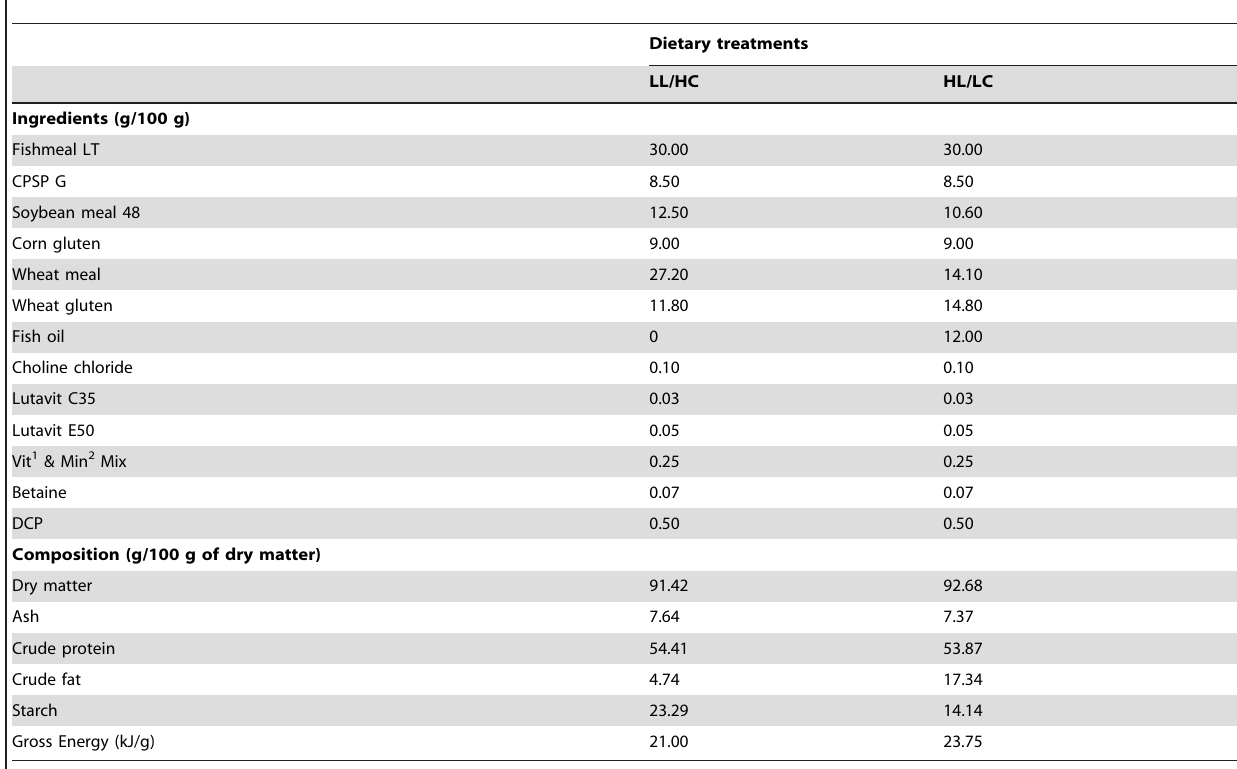
Table 1. Ingredients and composition of the experimental diets with different lipid/carbohydrate levels.